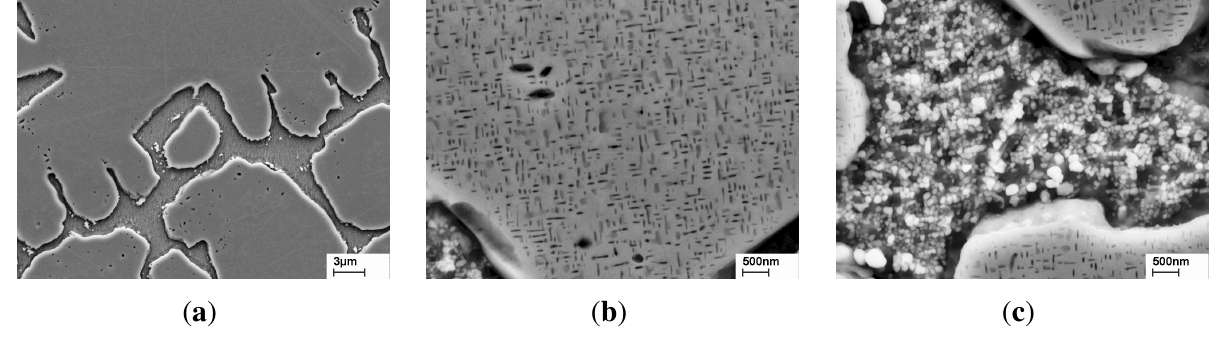
Figure 9. SEM-images (secondary electrons) of the alloy Ni-30%Cu-22%Cr after different heat treatments. Etched with molybdic acid. ( a ) Homogenization (1000 ◦ C, 4 h); ( b ) 800 ◦ C, 4 h, plate-shaped precipitates in the dendritic area; ( c ) 800 ◦ C, 4 h, spherical precipitates in the interdendritic